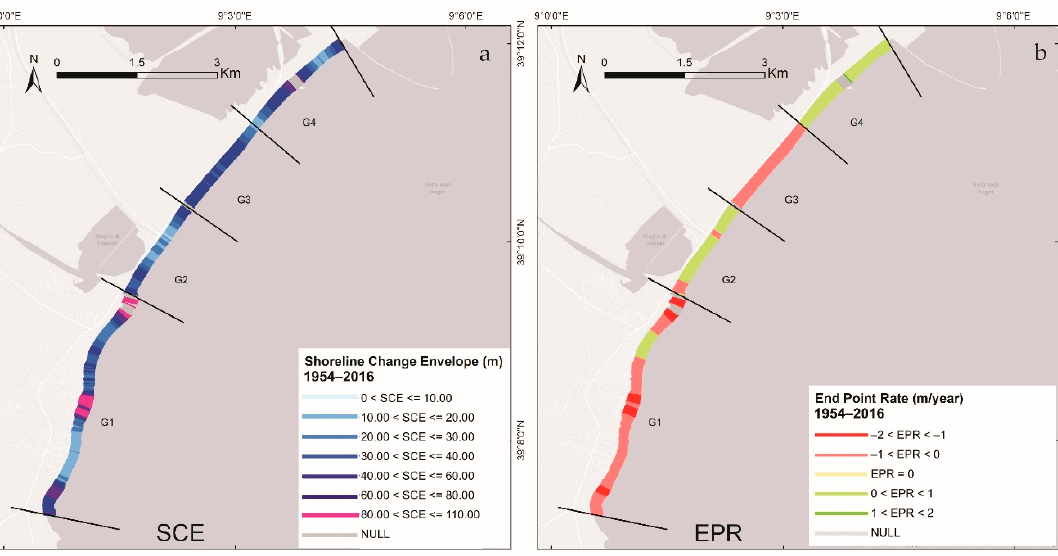
Figure 7. Maps showing the spatial distribution of shoreline change envelope (SCE) ( a ), end point rate (EPR) ( b ) and net shoreline movement (NSM) ( c ) along the Giorgino beach for the years 1954–2016, superimposed with the limits of the four discriminated sectors (G1–G4); SCE, NSM, EPR and LRR trends ( d ) plotted against distance (west to east), with the x-axis showing the limits of the G1–G4 sectors. Positive values of NSM and EPR indicate areas of accretion, whilst negative values indicate areas of shoreline retreat. 3.2. Uncertainty Estimation Measurements of shoreline positions are subject to positional uncertainties associated with natural influences over the shoreline position (wind, waves and tides) and sampling uncertainties (digitization, image positioning system errors) [59] that need to be accounted for in order to compute statistically reliable results. For each shoreline, the total error ( σ T ) was given by the modified formula (1) presented in Virdis et al. [63]: (cid:2026) (cid:3021) = (cid:3495)(cid:2026) (cid:3031)(cid:2870) + (cid:2026) (cid:3043)(cid:2870) + (cid:2026) (cid:3045)(cid:2870) + (cid:2026) (cid:3050)(cid:3045) (cid:2870) + (cid:2026) (cid:3047)(cid:3031)(cid:2870) (1)